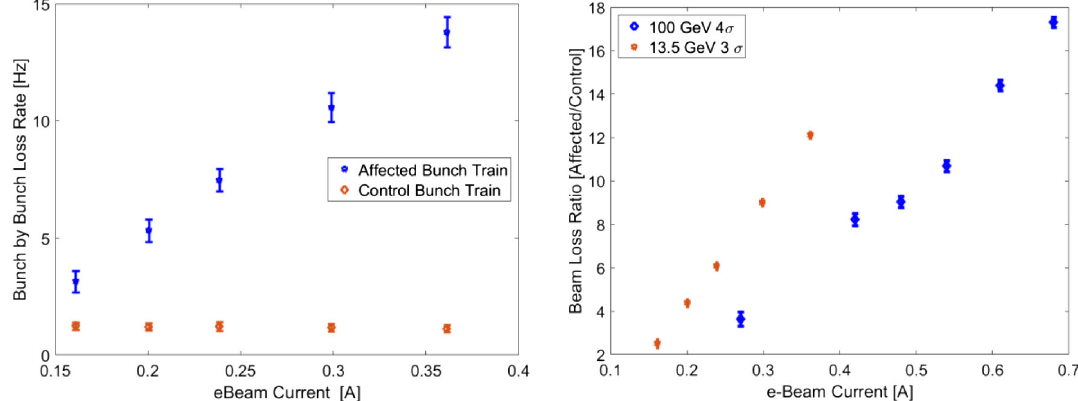
plots.FIG. 11. Average beam loss rate measured at the collimator vs beam current. For the affected bunch train, the loss rate is proportional to the electron beam current for both ion beam energies. For the control bunch train, the loss rate is not affected by the beam current.